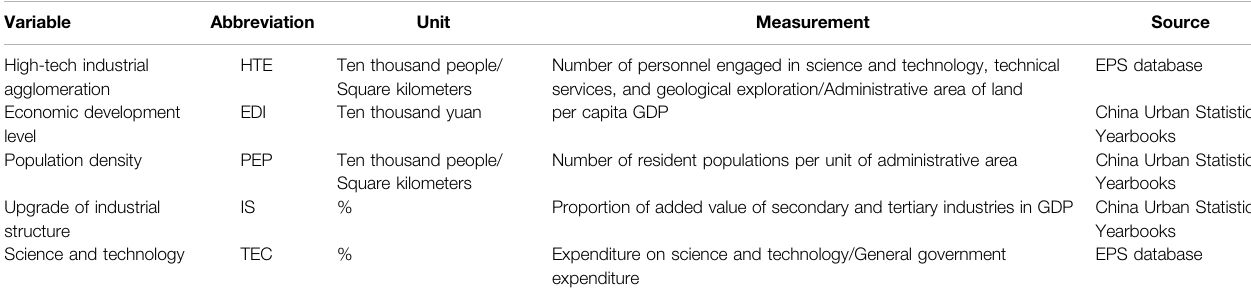
TABLE 2 | High-tech industrial agglomeration and control variables.